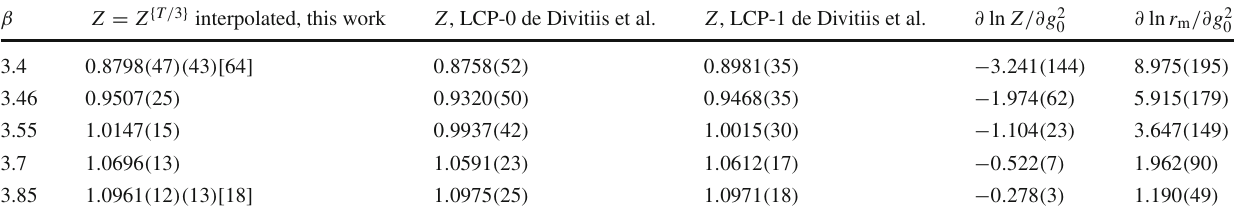
1 . 0 . 000 0 . 002 0 . 004 0 . 006 0 . 008 0 . 010 a 2 in fm 2 are displayed as: (σ stat )(σ syst ) [ σ total ] . In the last two columns we list ∂ ln Z /∂ g 2 for Z { T / 3 } , obtained by differentiating Eq. (C.1a) as well as 0 ∂ ln r /∂ g 2 via differentiating Eq. (5.5) m 0